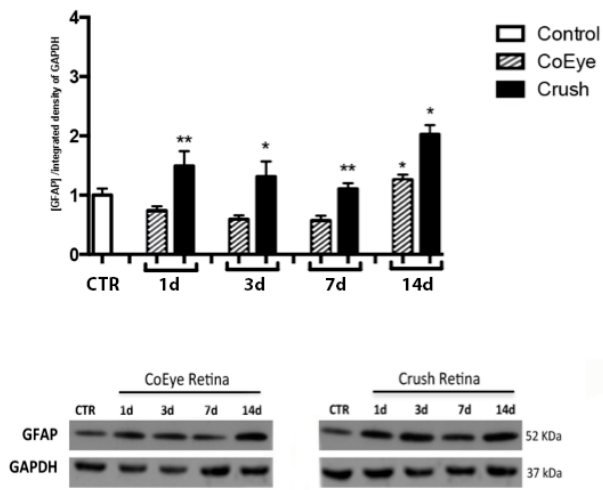
Figure 3. GFAP expression in the retina 1 to 14 days after crush. GFAP expression was increased in the Crush retinas at all time points analyzed ( n = 6 per group). Lower panels show representative images of the WB. * p < 0.05, ** p < 0.01. CoEye: contralateral eye; 1–14 d: 1 to 14 days after crush.